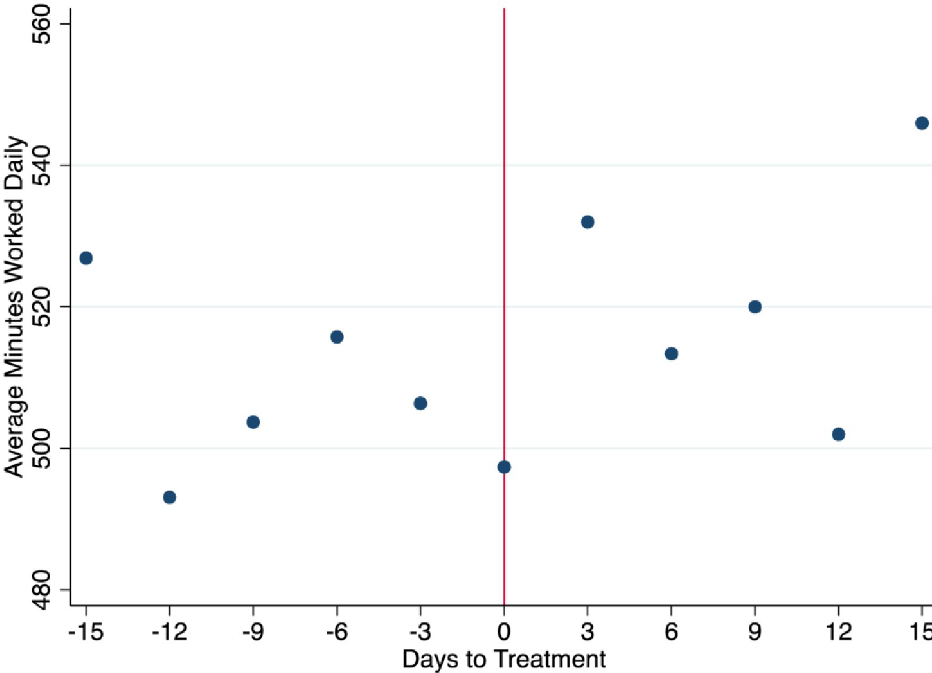
Fig 2. Ex post and ex ante average daily minutes worked.